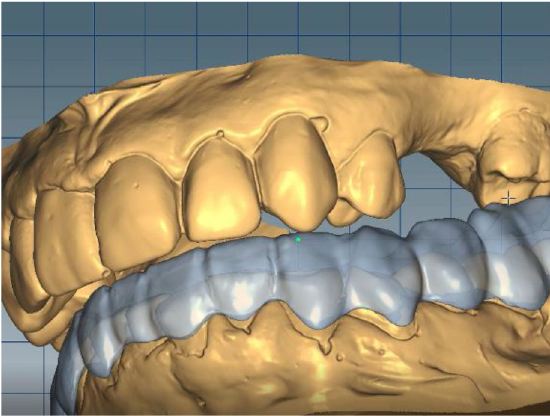
Figure 15. Splint design – lateral protrusion. Stage 4: Splint placement on the lower jaw and follow-up